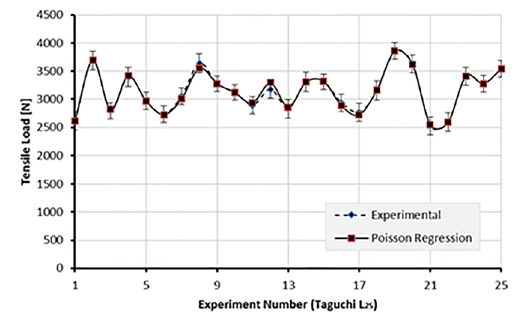
Figure 9. Comparison between the experimental results and the theoretical values of tensile load.